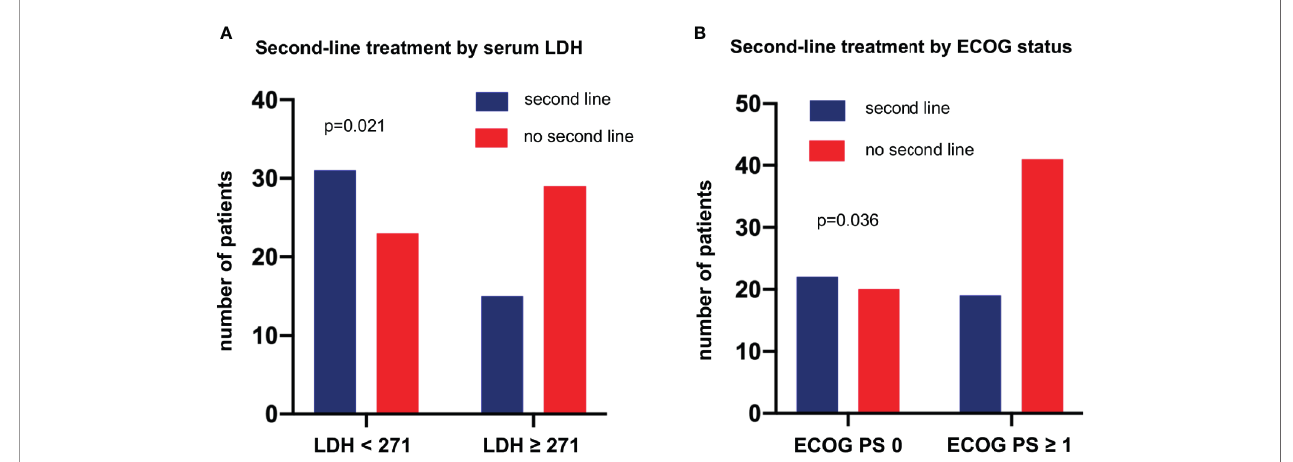
FIGURE 6 | Baseline parameters at initial diagnosis associated with lack of subsequent treatment in metastatic LCNEC. This analysis was performed in the subset of patients who received palliative systemic treatment and have complete follow-up available until death ( Figure 1 ). (A) The percentage of patients who missed second-line treatment was 66% (29/44) among patients with metastatic LCNEC with a higher serum LDH at diagnosis ( ≥ 271 U/l, i.e. above the median value, Table 1 ) vs. 43% (23/54) among patients with lower serum LDH levels (chi-square p = 0.0214). The LDH cut-off was based on the median value of the entire study population ( Table 1 ). (B) The percentage of patients who missed second-line treatment was 68% (41/60) among patients with metastatic LCNEC and an ECOG performance status (PS) >0 at diagnosis vs. 48% (20/42) among patients with an ECOG PS 0 (chi-square p = 0.0357). The LDH and ECOG PS cut-offs were based on the median values of the entire study population ( Table 1